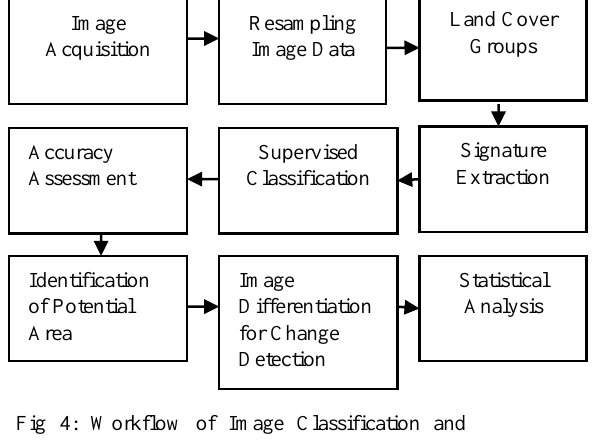
Fig 4: Workflow of Image Classification and Change